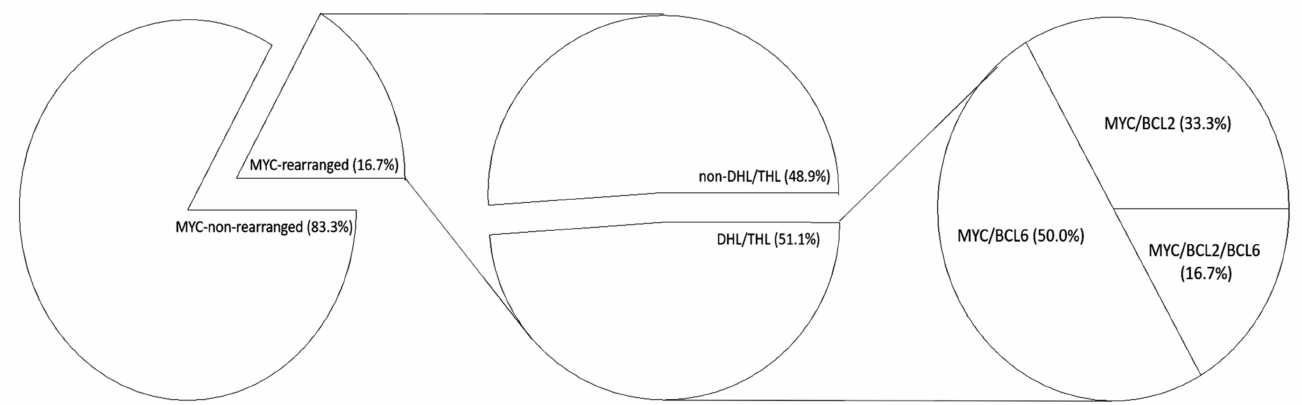
Figure 1. Pie-charts showing our DLBCL cohort ( n = 282) distribution based on the presence or absence of MYC- rearrangement ( left ), and multiple hit status ( middle ), as well as the stratification of the multiple hit group based on concurrent BCL2 and/or BCL6 rearrangements ( right ). The ratio of rearranged BCL2:BCL6 was 2:3. DHL, double hit lymphoma; THL, triple hit lymphoma.